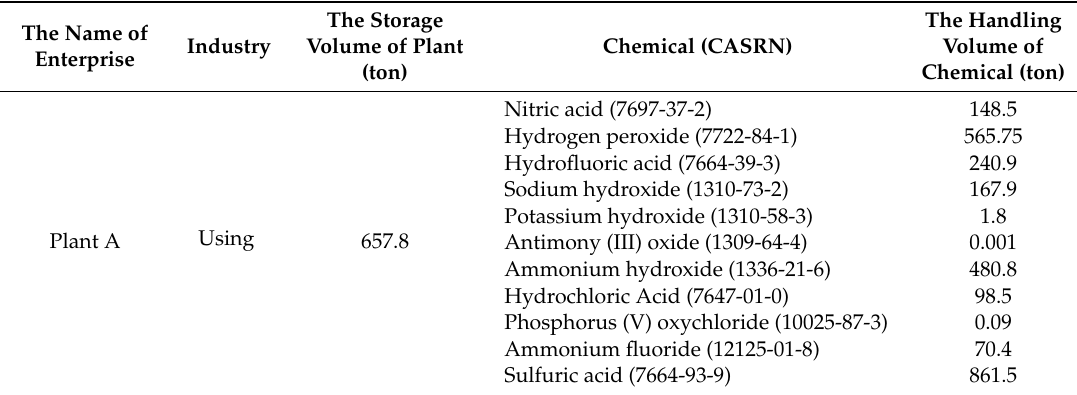
Table 1. Chemicals and their handling volume of example